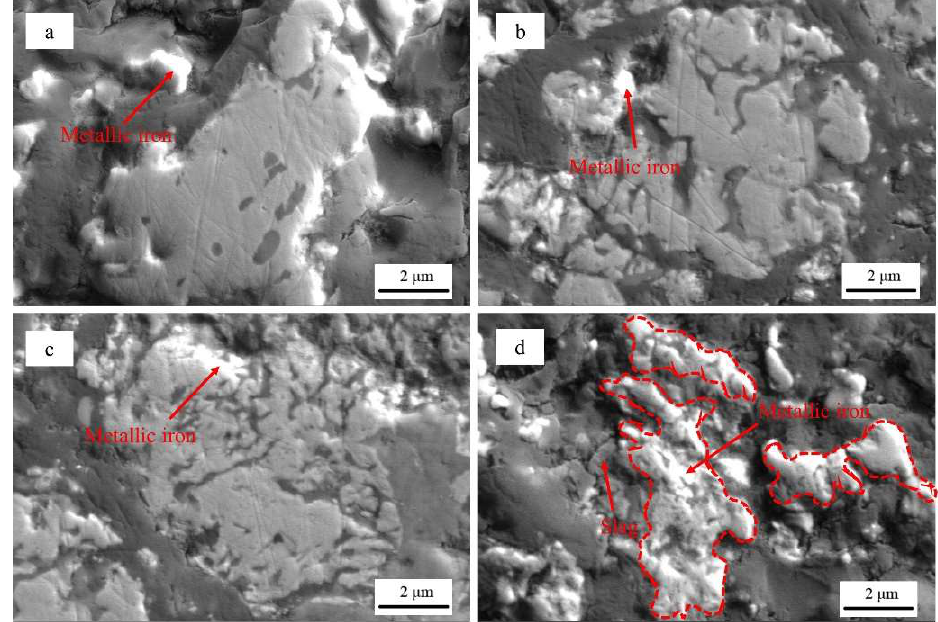
Figure 6. Microstructure of samples isothermally reduced with H 2 : ( a ) 800 °C, ( b ) 900 °C, ( c ) 1000 °C, and ( d ) 1100 °C.